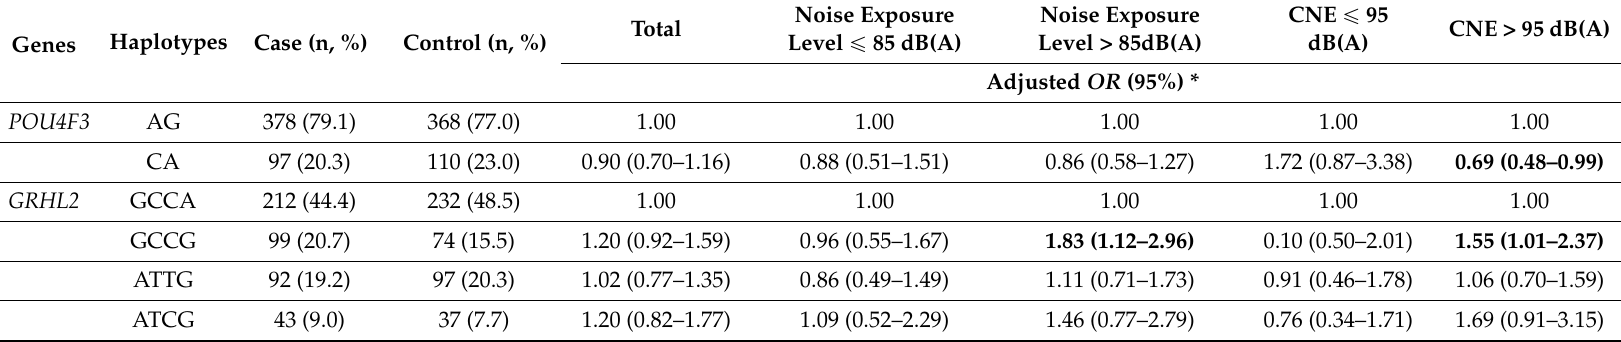
Table 4. Assessment of association between the haplotypes and